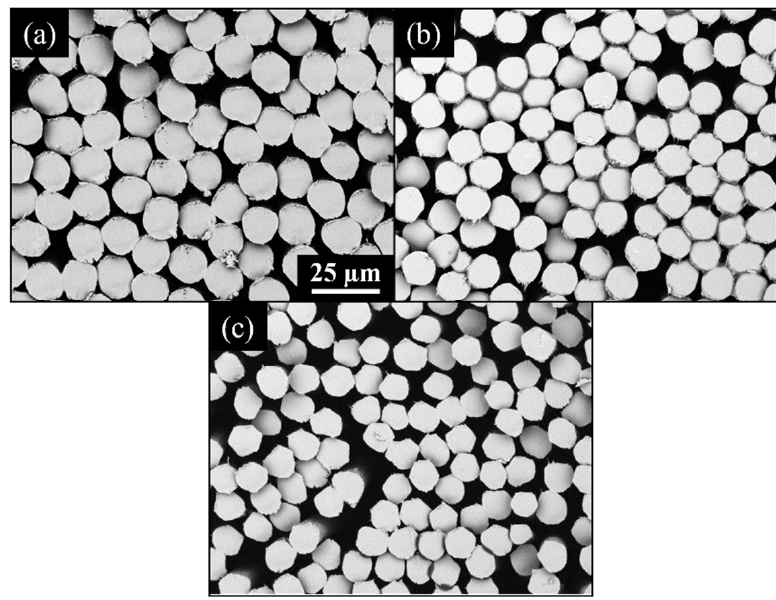
Figure 4. SEM images showing the cross-sectional shape for ( a ) 60C-8×, ( b ) 60C-10×, and ( c ) 60C- 13×. All images are at the same scale. Table 2. The mean E L values, the breaking stress, the mean E T values, and the densities for the WFs and CFs investigated in this study. The E L and density values were measured using a Favimat. Standard deviations are indicated in the round brackets. The confidence intervals (95% confidence) have been provided for the modulus values. The number of measurements is indicated after each confidence interval in curly brackets.